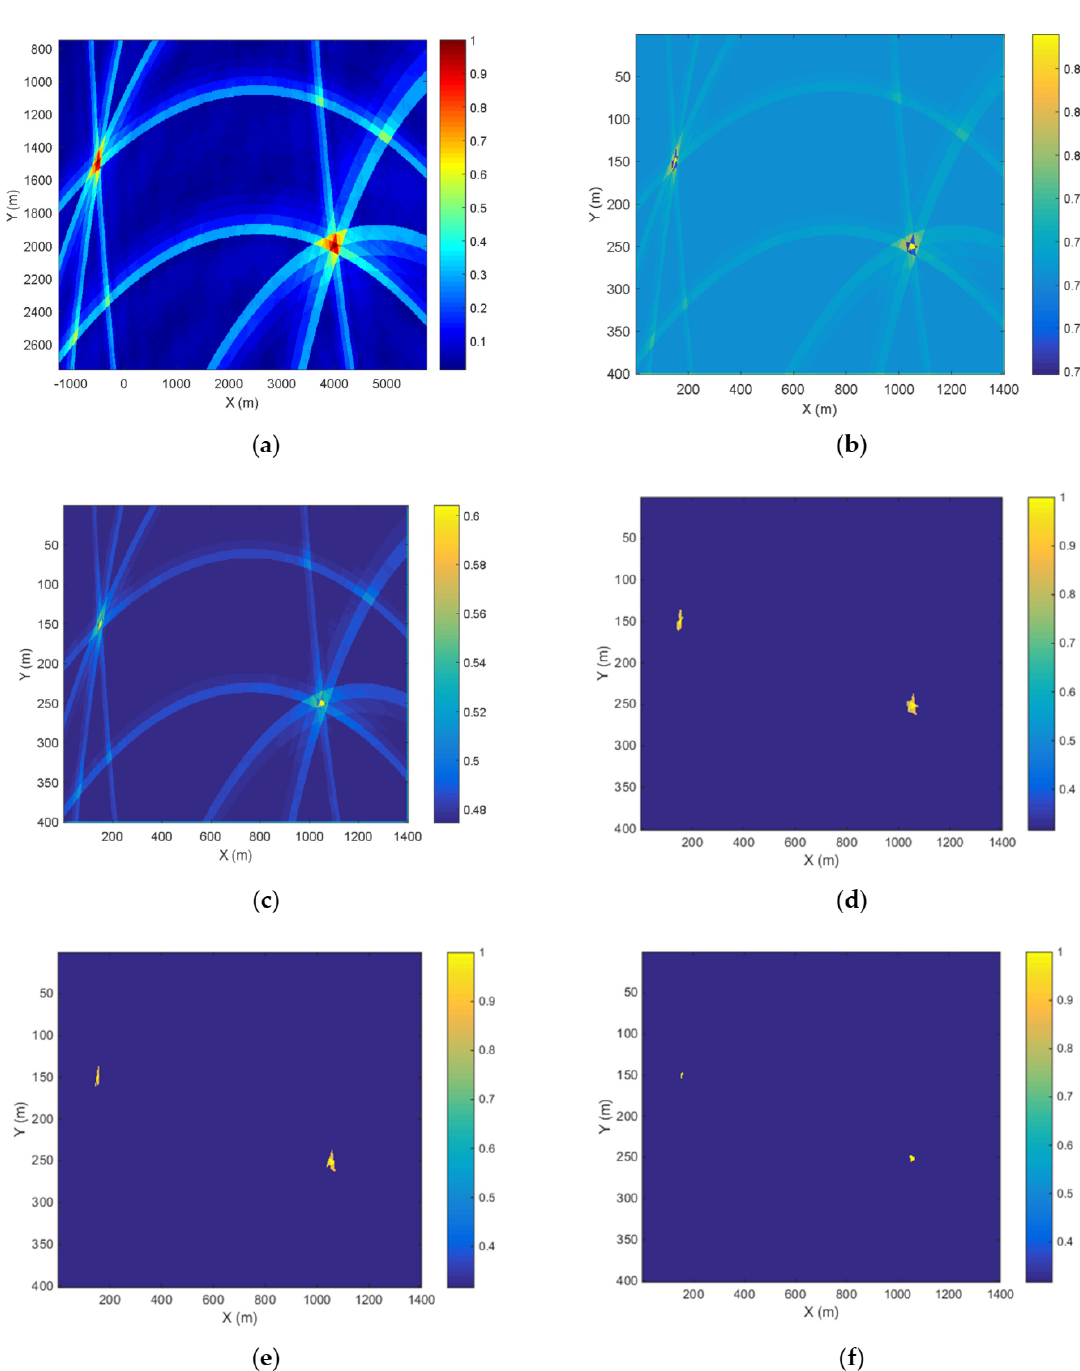
Figure 12. Multi-source fusion results with regard to multiple targets scenario. ( a ) Multi-source fusion result; ( b ) The weight distribution of the contrast ratio based on the sliding window; ( c ) The exponential weighted likelihood ratio distribution corresponding to the fusion result; ( d ) The detec- tion result using LRB detection method with a single platform; ( e ) The detection result using LRB detection method with multiple platforms; ( f ) The detection result using LRWB detection method with multiple